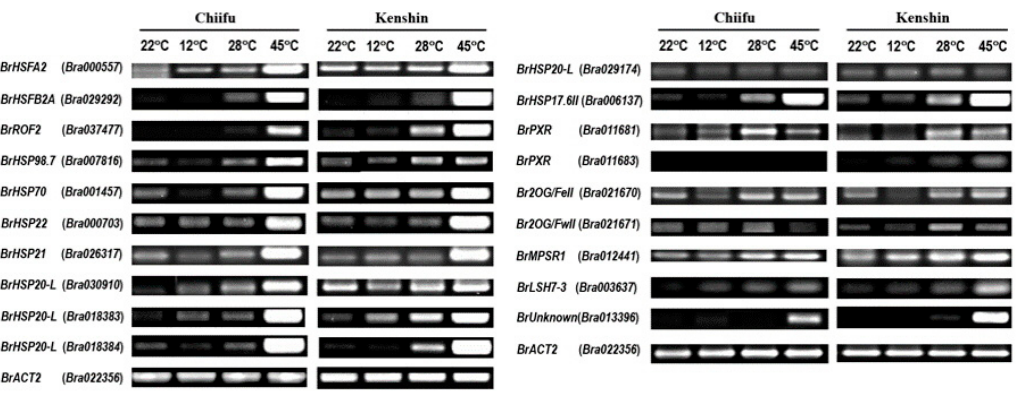
Figure 5. RT-PCR analysis of selected genes identified by microarray analysis. The expression levels of these genes obtained by microarray analysis are summarized in Table S16.